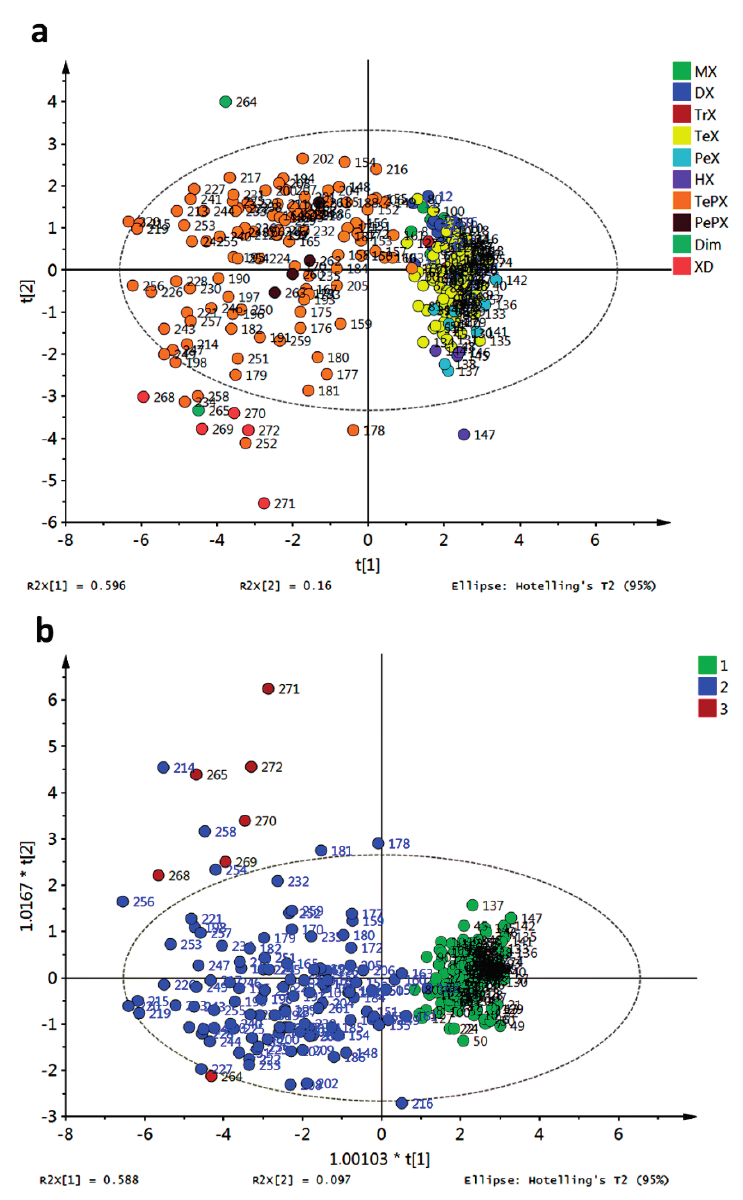
Figure 14. Supervised multivariate analyses from affinity values for docking of xanthones with target enzymes. ( a ) PLS-DA score plot; ( b ) OPLS-DA score plot. Group 1: non-prenylated; Group 2: prenylated; Group 3: Dim and